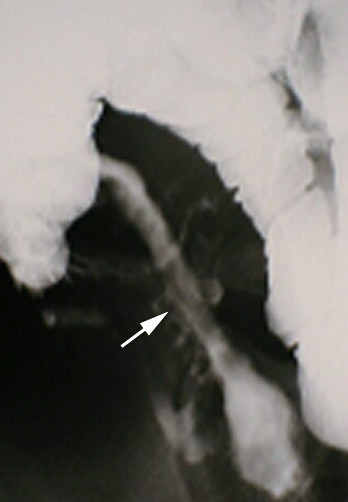
Small bowel double-contrast enteroclysis (detail) showing a stricture (arrow) of the terminal ileum with a thickening of the wall.